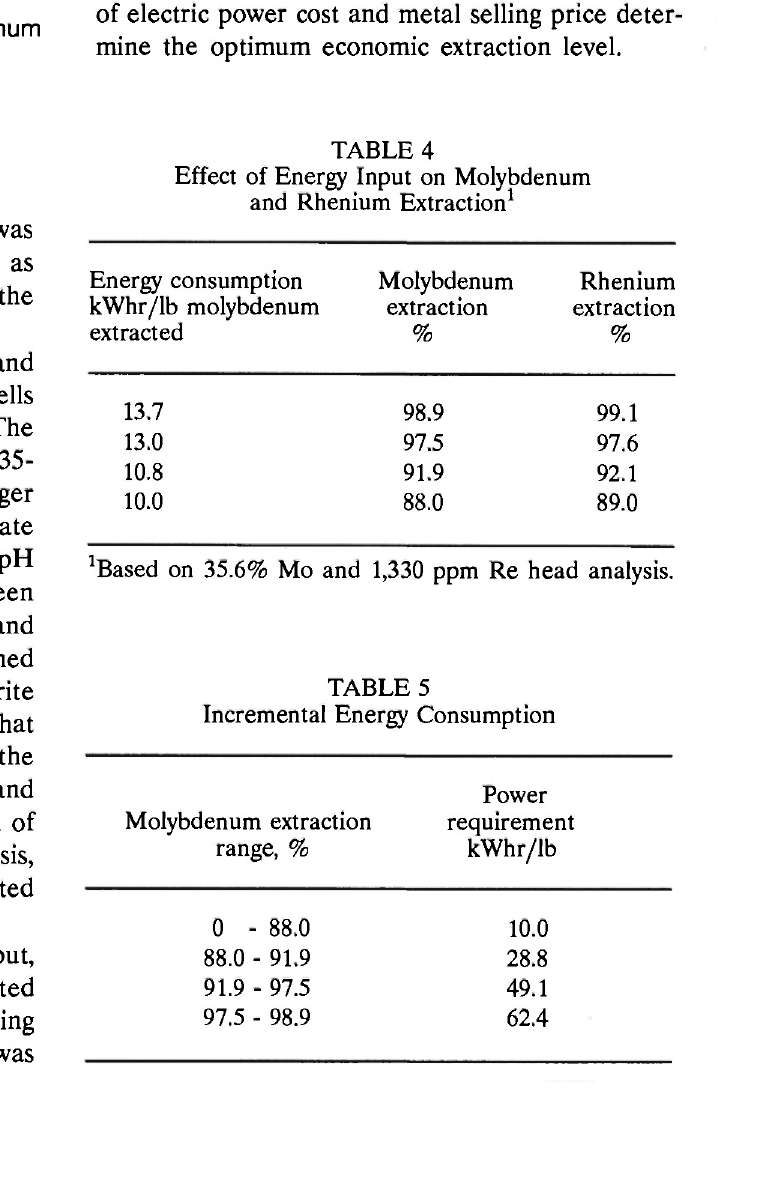
Fig. 6: Flow sequence for recovery of molybdenum and